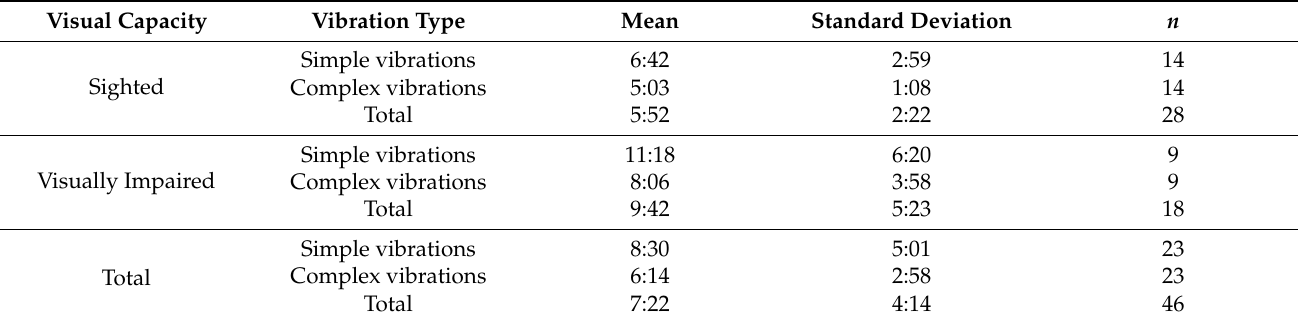
Table 3. Descriptive statistics for the test time (in minutes:seconds), grouping VI and sighted subjects as a function of the vibration patterns used. Visual